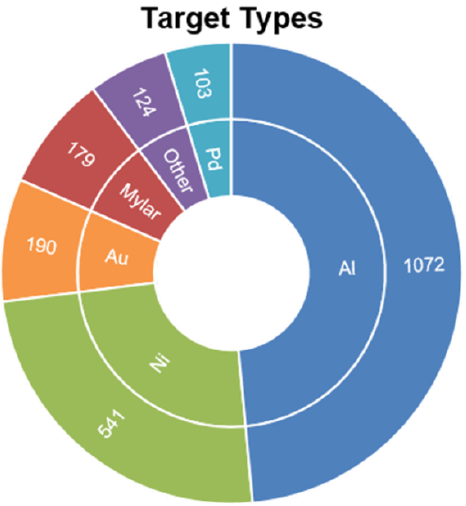
Figure 24. Pie chart showing the total number of shots fired per target material .